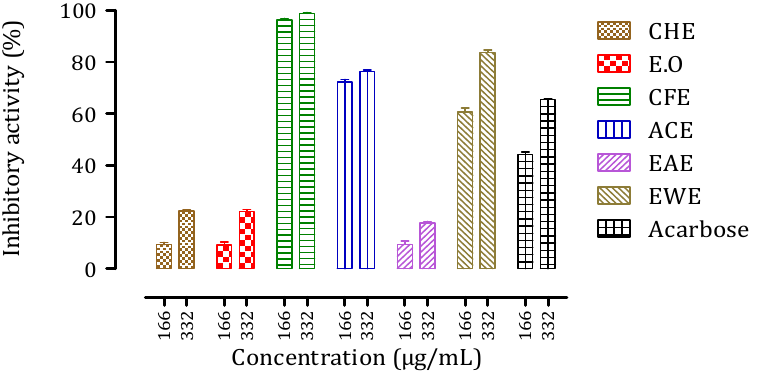
Figure 5. Inhibitory activity of C. aurantium peel extracts and Acarbose against